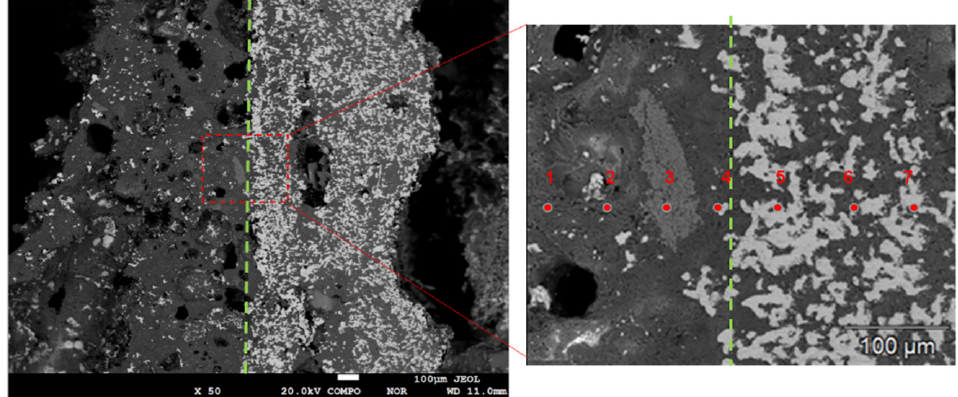
Figure 15. SEM of the cross section of DC3; the green dot line was borderline of raw ore and con- centrate.